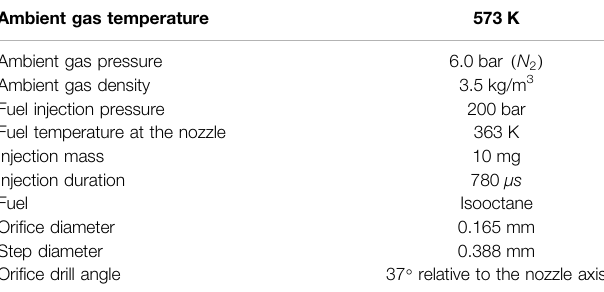
TABLE 2 | Spray G standard operating conditions and injection characteristics (ECN,